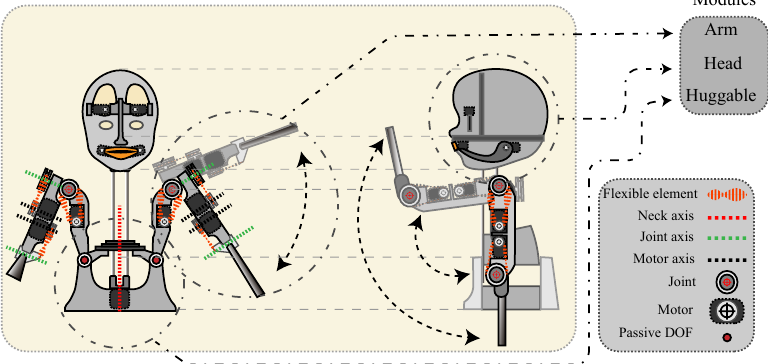
Figure 4. Mechanical structure and modules implemented in CASTOR. The right lower box summarizes the elements integrated into the mechanical structure. The right upper box presents the modules of the